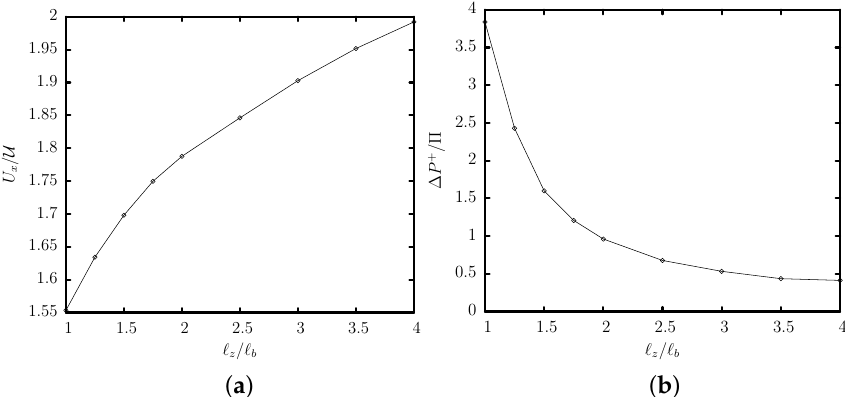
Figure 7. Steady-state variation with the channel height (cid:96) z of ( a ) the translation velocity U x and ( b ) the additional pressure difference ∆ P + , for a capsule with a / (cid:96) b = 0.55 and Ca = 0.1 flowing in a trapezoidal channel with base ratio (cid:96) a / (cid:96) b =